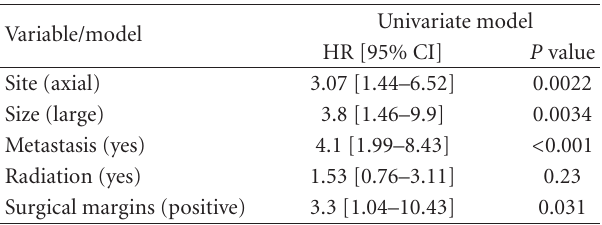
Table 2: E ff ects of pre-treatment and treatment variables in univariable Cox proportional hazard